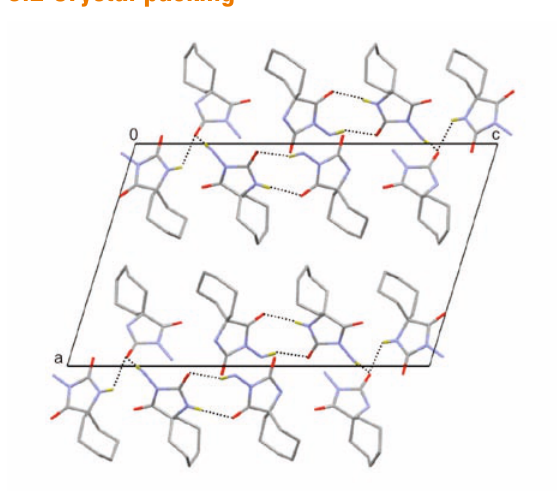
In (II) all available hydrogen bond donors and acceptors are involved in the hydrogen bonding